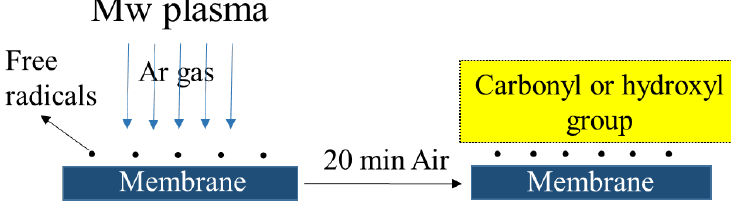
Figure 5. Functionalization of membranes by atmospheric exposure subsequent to Ar plasma treatment.